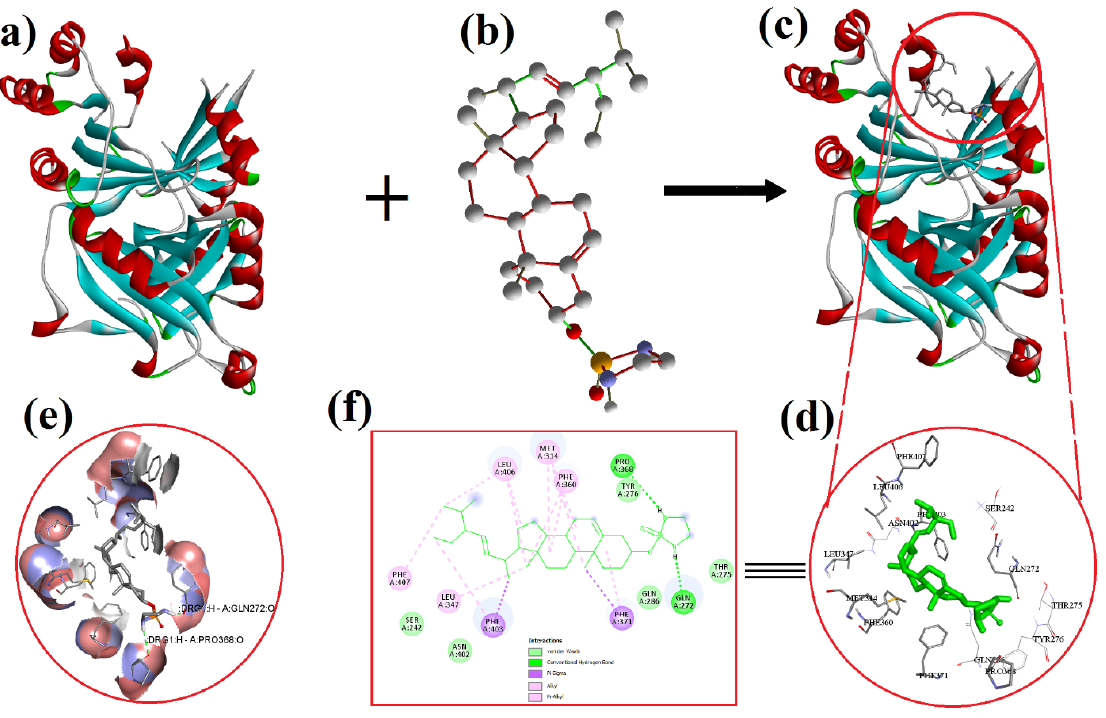
Figure 4 : Binding mode for ligand (4) with receptor (PDB ID 1TFZ); Molecular docking interaction of (a) receptor, (b) compound 2 (c) best docked pose showing the active site where the compound interact (d) binding pose of the compound to the receptor showing various interactions and (f) a combined Interaction diagram of ligand to receptor and (e) soft atom charge surface of compound